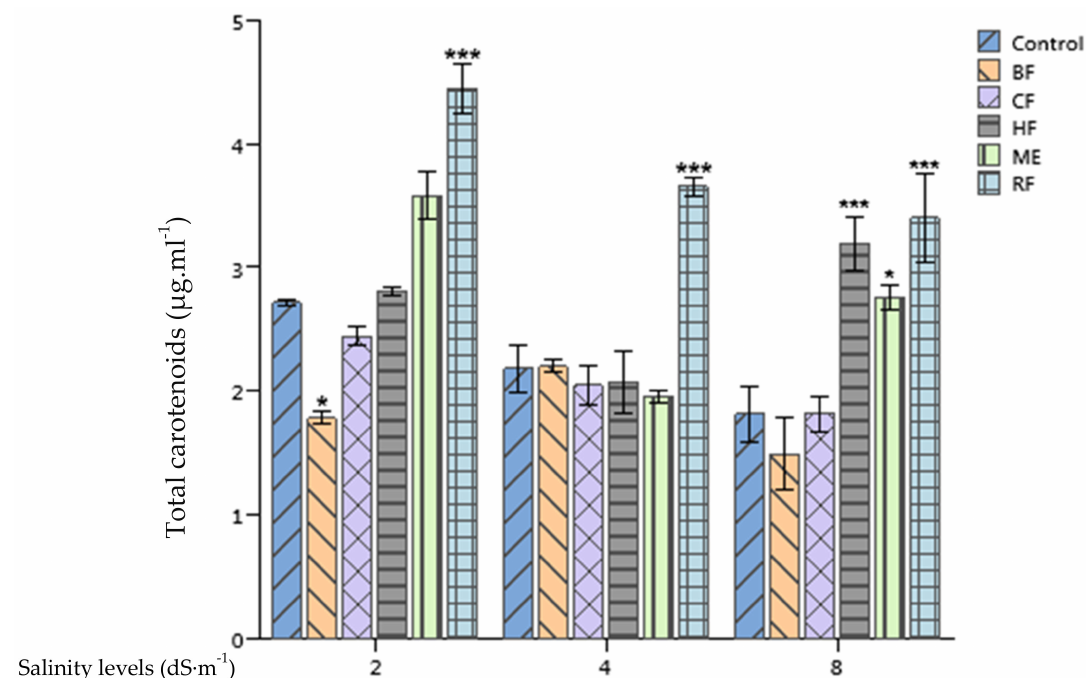
Figure 6. Effect of priming tomato seeds with Ulva lactuca methanol extract (ME), hexane fraction (HF), chloroform fraction (CF), n-butanol fraction (BF), and residual fraction (RF) under different salinity levels (2, 4, 8 dS · m − 1 ) on total carotenoids concentration of tomato leaves. Mean ± SD values followed by asterisks indicate significant differences between treatments and the control (* p < 0.05; *** p <